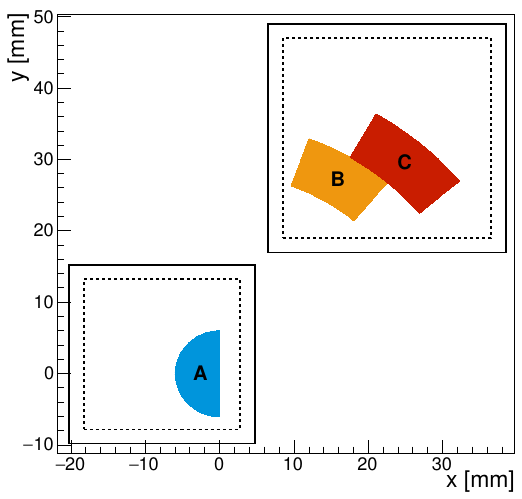
Figure 1 . De(cid:12)nition of the three pseudorapidity regions A (blue), B (yellow) and C (red) on the Arm2 detector seen from IP1. The origin of the reference frame is centered on the projection of beam center on the detector during Fill 3855. The left and the right squares correspond to the small tower and the large tower, respectively. All analysis regions are chosen within a (cid:12)ducial area (dashed line), which is 2 mm inside the edges of the towers (solid line).